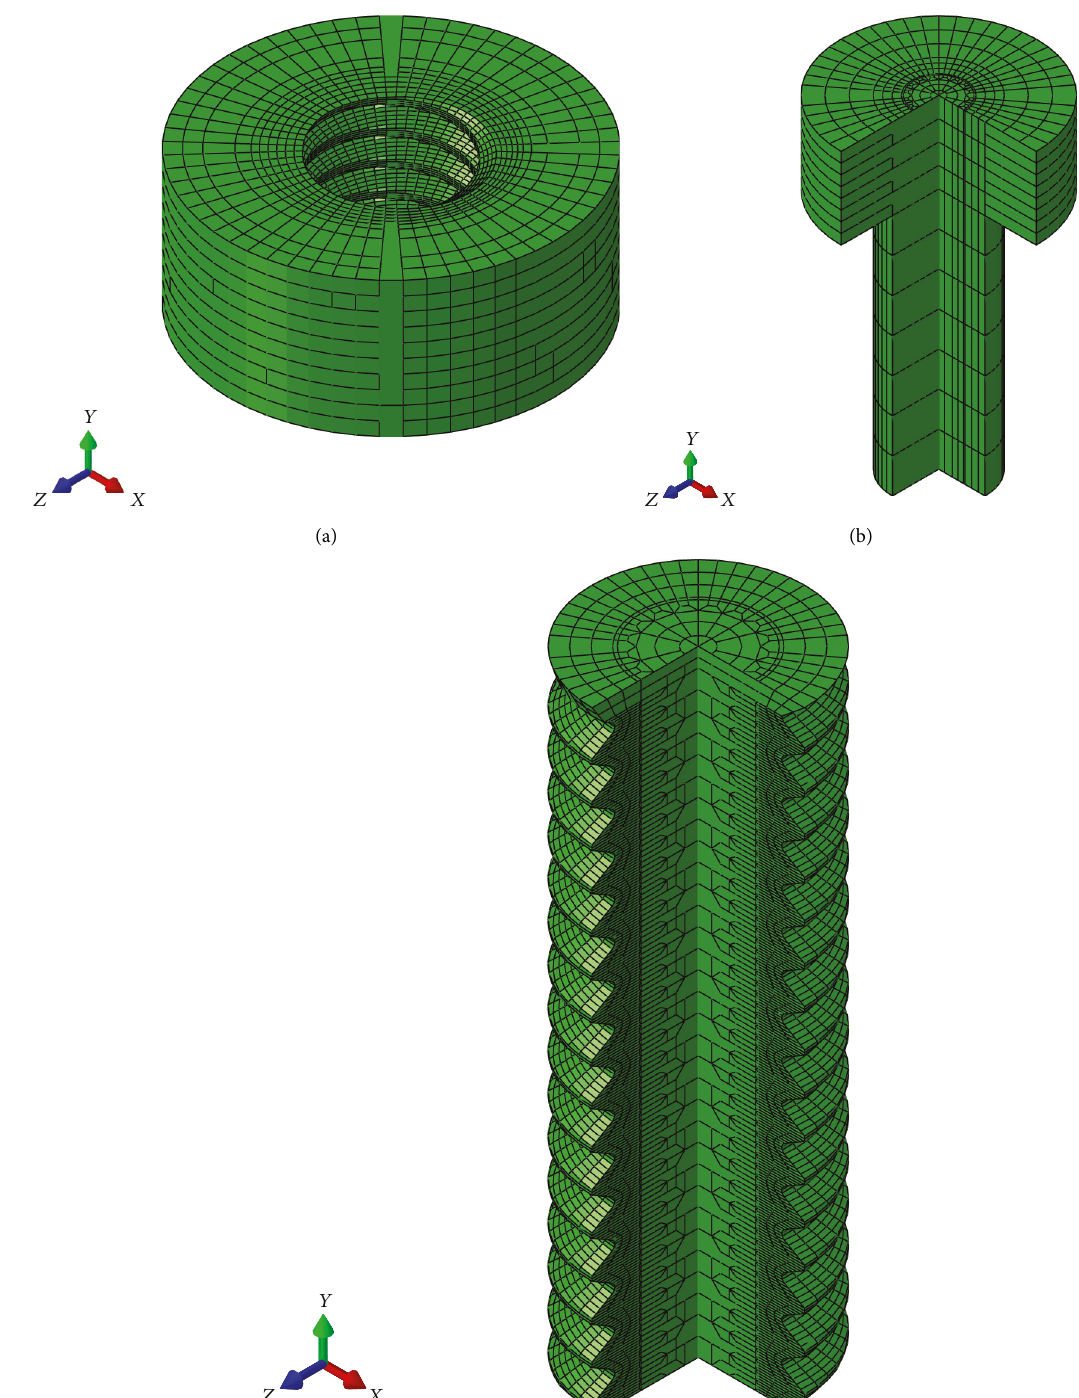
Figure 5: Hexahedral model. (a) Nut mesh. (b) The bolt head mesh. (c) The screw thread